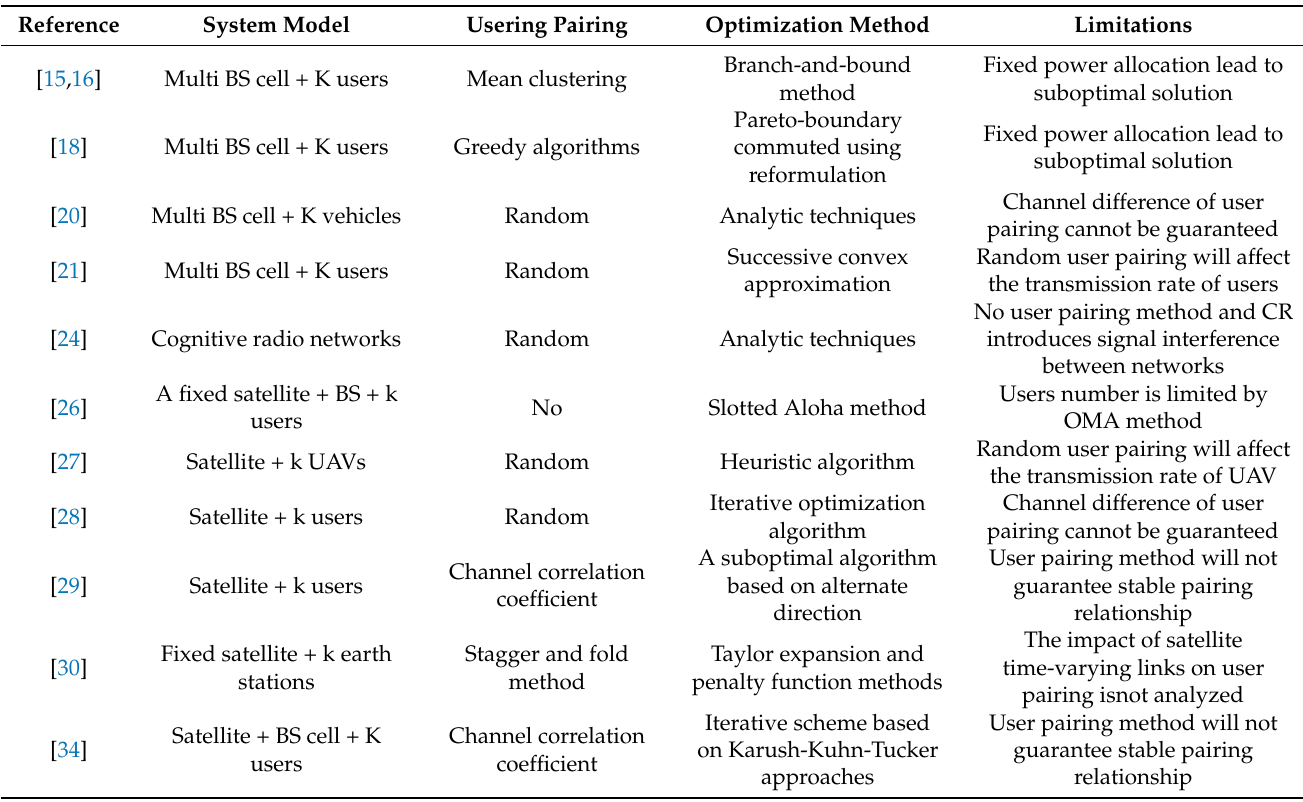
Table 1. NOMA for integrated terrestrial–satellite